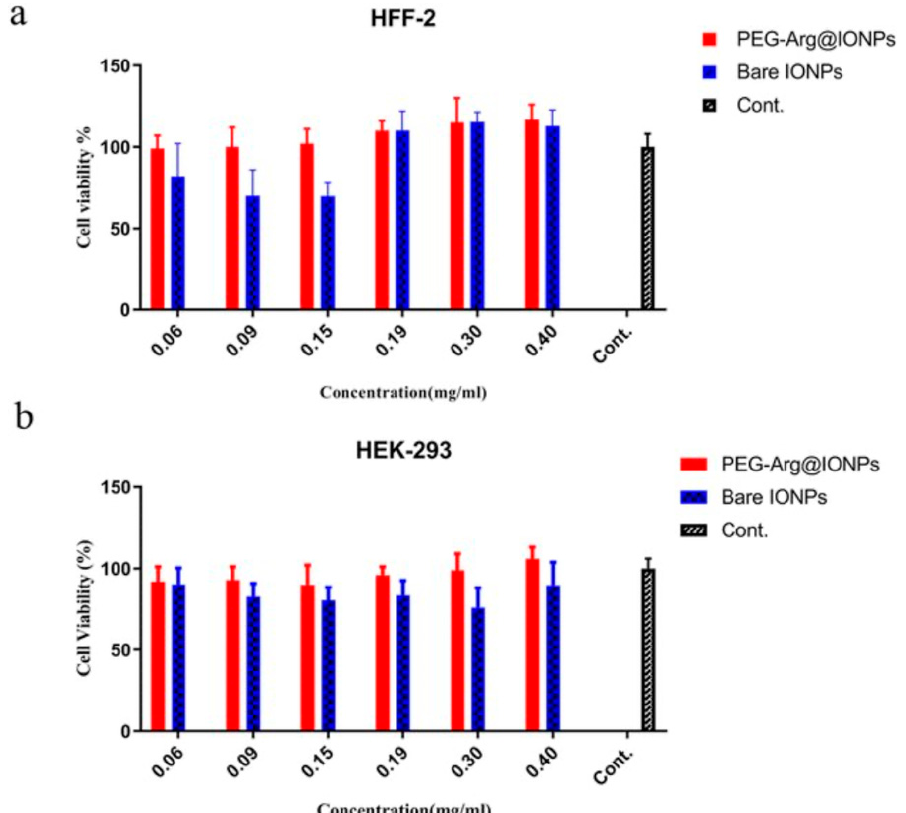
Figure 6. Cytotoxicity analysis of human fibroblast (HFF-2, a ) and human embryonic kidney (HEK-293, b ) cell lines with varying concentrations of SPIONs. Unedited image obtained from Nosrati et al. [110] following the Creative Commons License, (http://creativecommons.org/licenses/by/4.0/). (accessed on 20 April 2021).